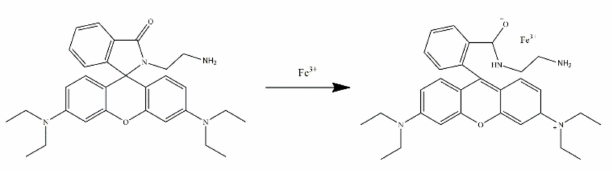
Figure 25. The proposed sensing mechanism of RhB-EDA (Table 1, No. 32) for Fe 3+ [61]. Zhang J., et al. reported a rhodamine-based sensor named LXY (Table 1, No. 33) for quantitative and qualitative Fe 3+ detection in HEPES buffer (10 mM, pH = 7.4)/CH 3 CN (2:3,